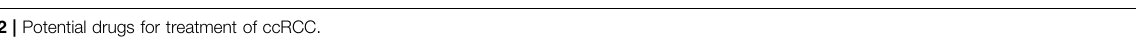
TABLE 2 | Potential drugs for treatment of ccRCC.